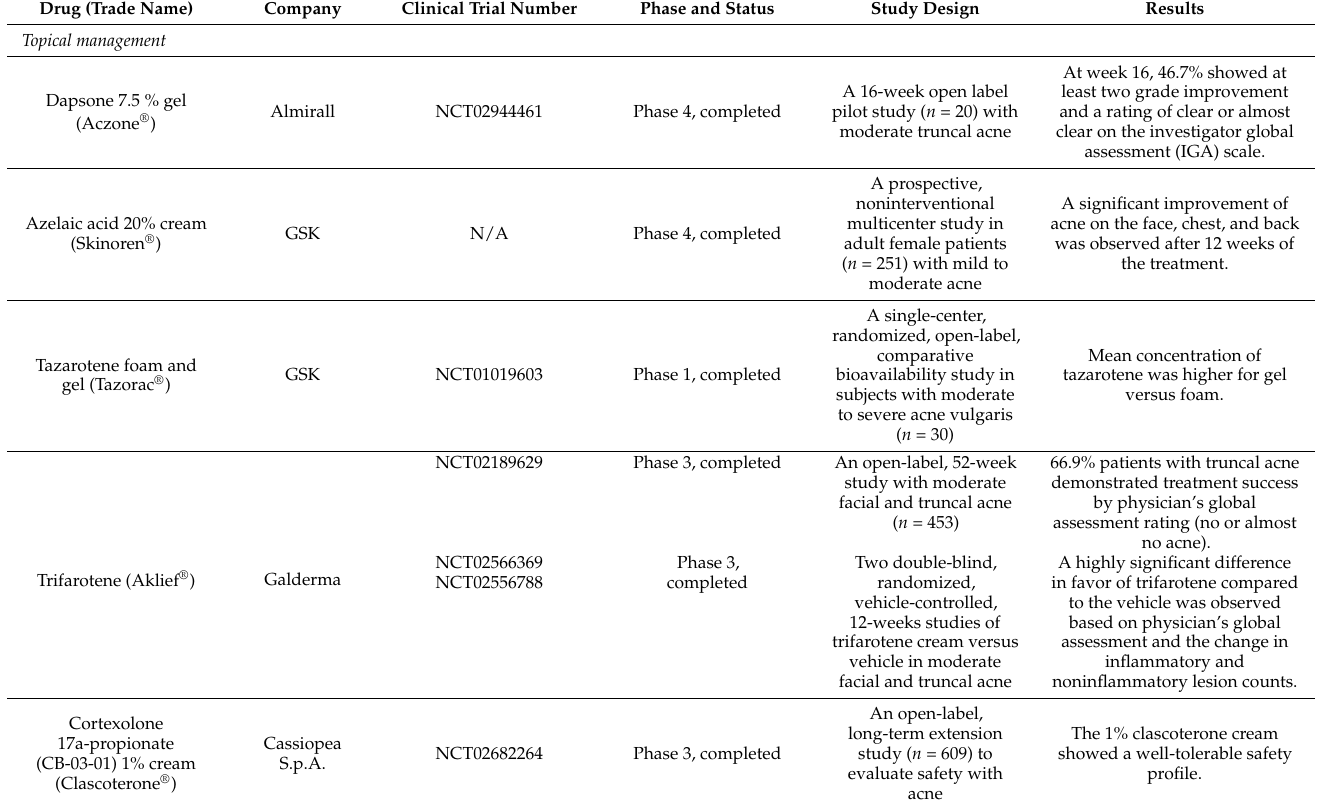
Table 2. Summary of clinical trials for management of truncal